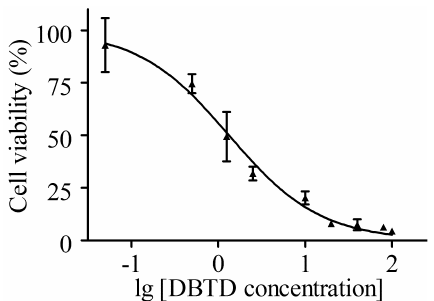
Figure 1. Toxicity of dibutyltin dilaurate (DBTD) on the HL7702 cell line. Cells were treated with a series of diluted DBTD (100, 80, 40, 20, 10, 5, 2.5, 1.25, 0.50, 0.05, and 0 μmol/L) for 24 h. Data were obtained from three independent experiments ( n = 3). Values are mean ± SD.